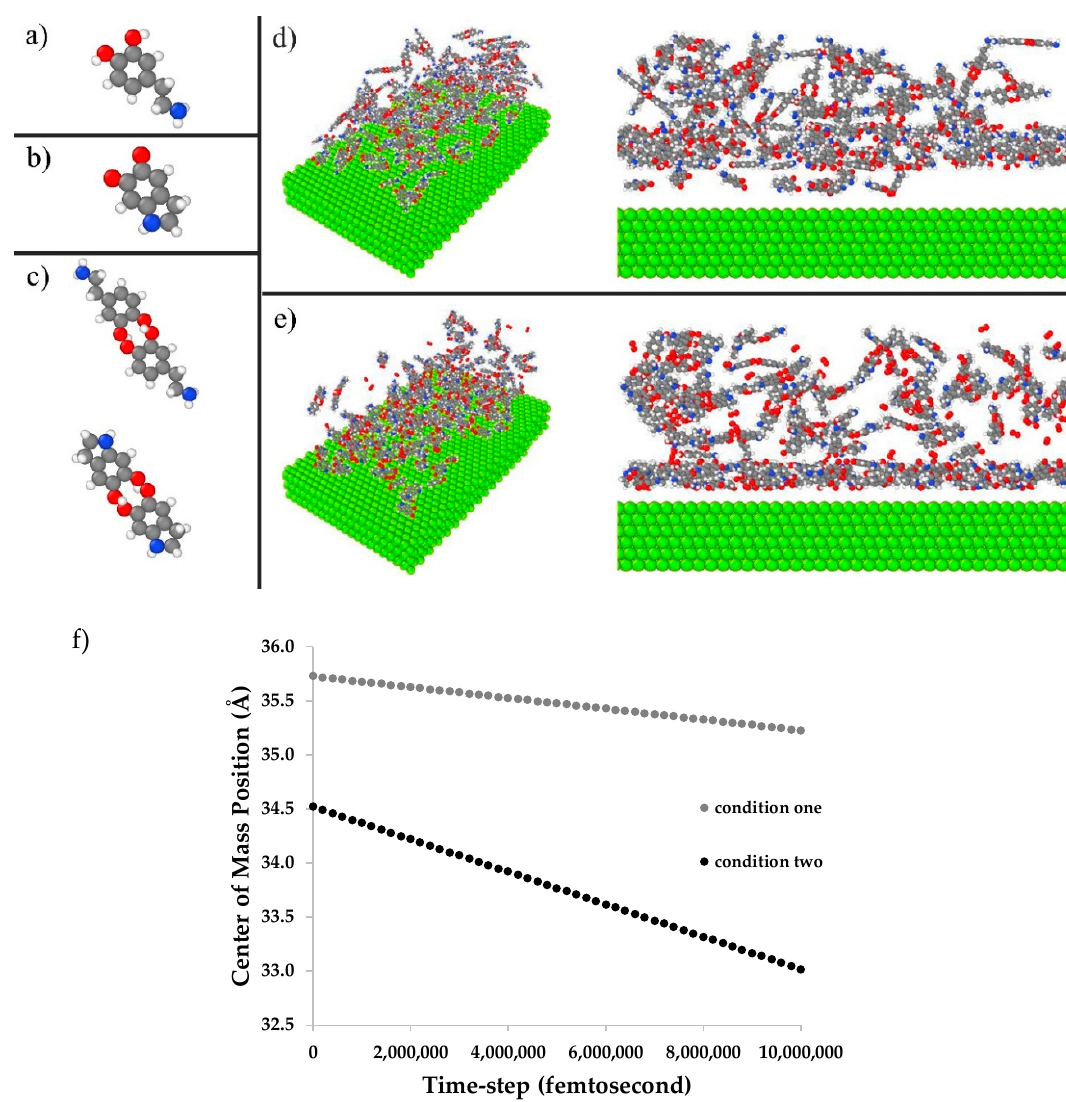
Figure 7. Molecular dynamic simulation: ( a ) Dopamine monomer and ( b ) indolequinone monomer; ( c ) dimers; ( d ) condition one; ( e ) condition two; (colors definition: green: Mg; gray: C; white: H; red: O and blue: N); ( f ) center of mass versus time-step.